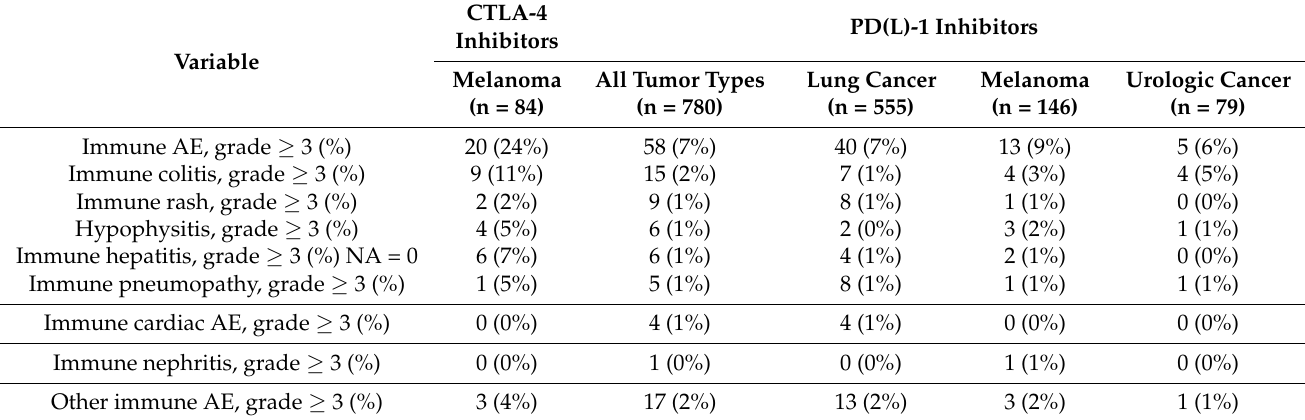
Table 2. Description of irAEs. irAEs = immune-related Adverse